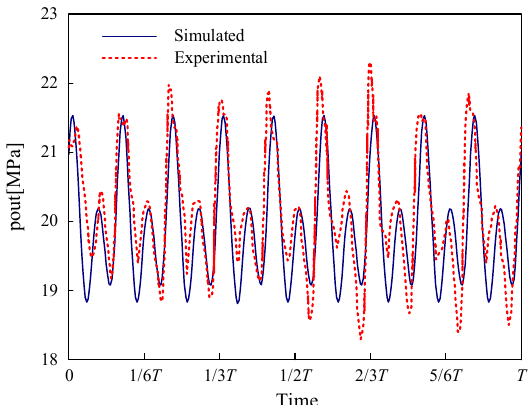
Figure 9. Discharge pressure comparison between the simulated and measured results (under the discharge pressure of 20 MPa and rotational speed of 1500 r/min).